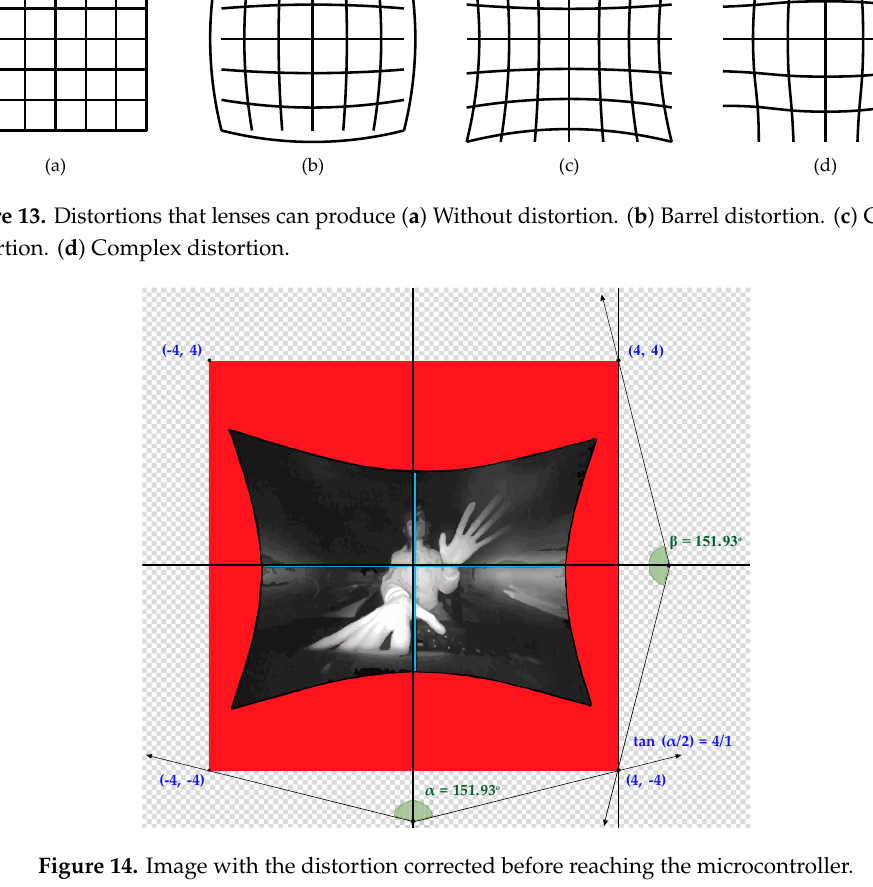
Figure 14. Image with the distortion corrected before reaching the microcontroller.